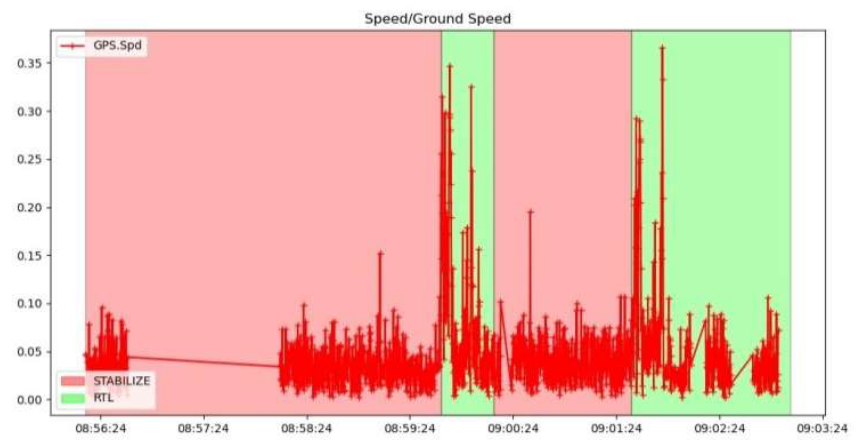
Figure 33. Relative speed of the drone to the ground.